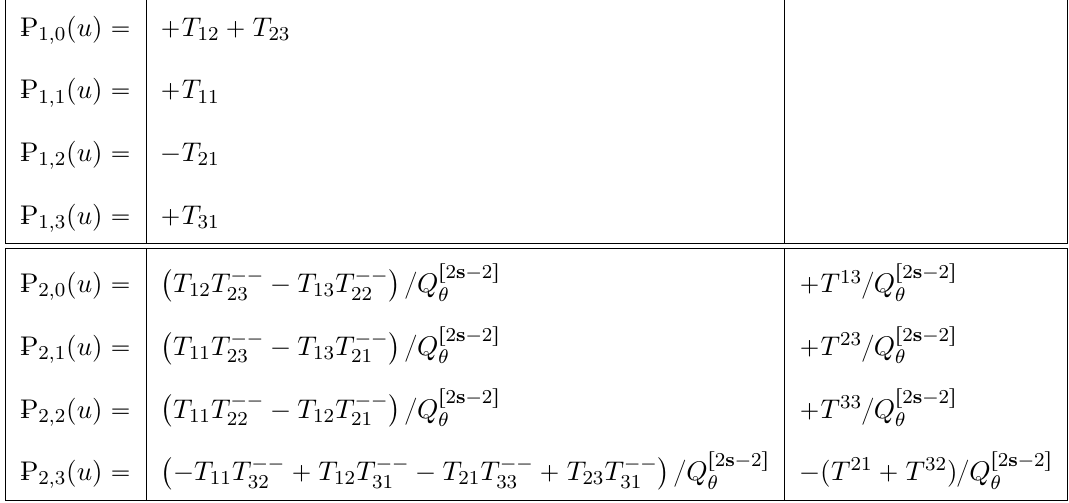
Table 1 . sl p 3 q Principal operators in terms of monodromy matrix